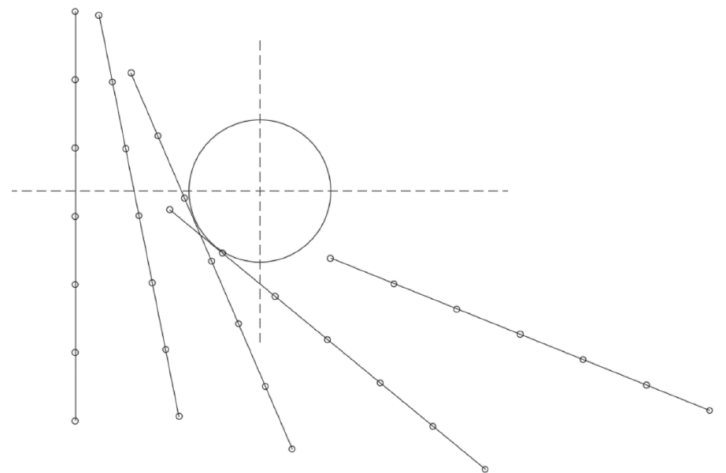
Figure 9. Trajectory of a single rigid fibre with six segments around a cylinder where the fibre length is